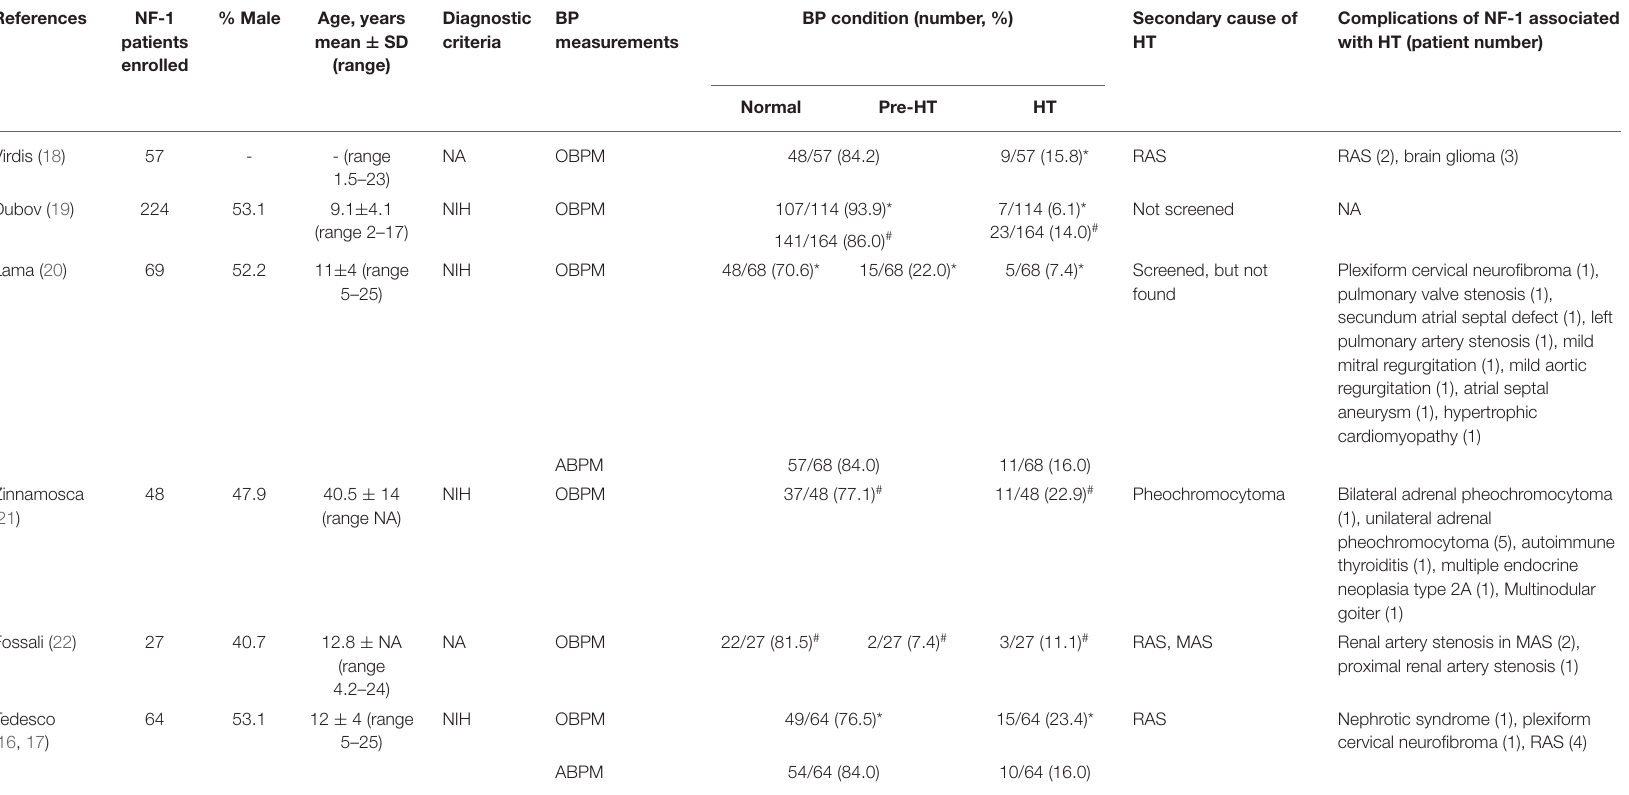
TABLE 2 | Summary of clinical characteristics of eligible studies included in the literature